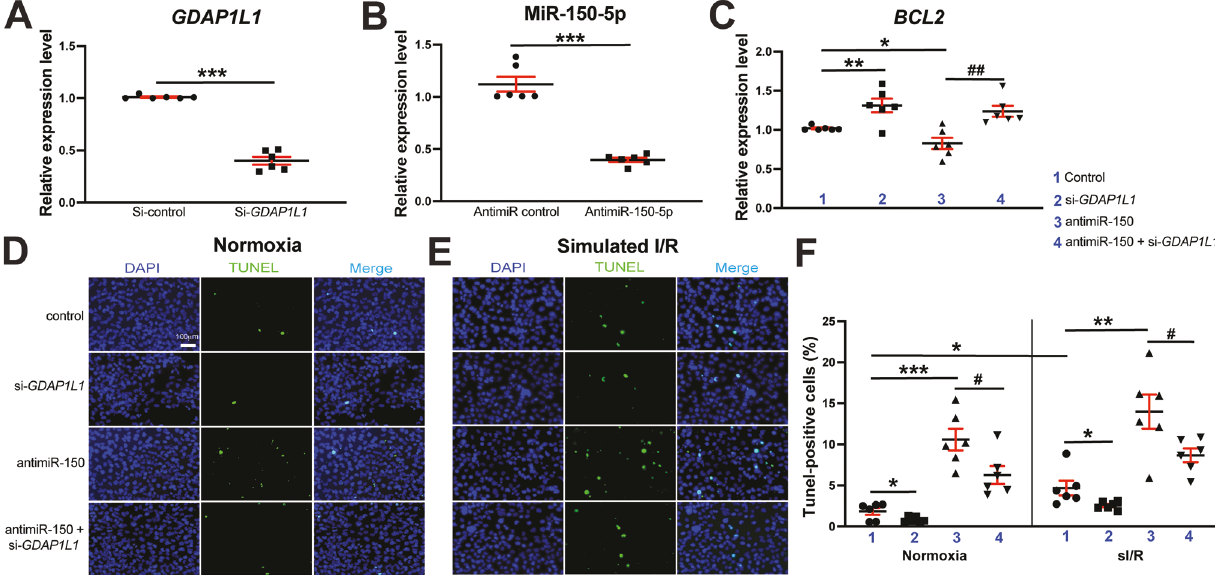
Fig. 8 GDAP1L1 is required for miR-150-dependent inhibition of human cardiomyocyte apoptosis. A , B AC16 cells were transfected with control scramble siRNA (si-control) or GDAP1L1 siRNA (si- GDAP1L1 ) ( A ) and with anti-miR control scramble or anti-miR-150 ( B ). QRT-PCR for GDAP1L1 ( A ) or miR-150 ( B ) was conducted to check the knockdown ef fi ciency. Data were normalized to GAPDH ( A ) or U6 SNRNA ( B ) and expressed relative to controls. N = 6 per group. Unpaired two-tailed t -test. *** P < 0.001 vs. si-control or anti-miR control. C QRT-PCR expression analysis of anti-apoptotic BCL2 in human cardiomyocytes (HuCMs) transfected with 4 different groups as indicated. N = 6. BCL2 expression compared to GAPDH was calculated using 2 − ΔΔ Ct , and data are presented as fold induction of BCL2 expression levels normalized to control (si- control or anti-miR control). One-way ANOVA with Tukey multiple comparison test. * P < 0.05 or ** P < 0.01 vs. control. ## P < 0.01 vs. anti-miR- 150. D – F RNA interference with GDAP1L1 protects HuCMs from the pro-apoptotic effects mediated by anti-miR-150. HuCMs were transfected as indicated and subjected to in vitro simulation of I/R (hypoxia/reoxygenation) [sI/R (H/R)]. TUNEL assays were then conducted in both normoxic ( D , F ) and sI/R conditions ( E , F ). Scale bar = 100 μ m. The percentage of apoptotic nuclei (green) was calculated after the normalization of total nuclei (blue). N = 6. One-way ANOVA with Tukey multiple comparison test. * P < 0.05, ** P < 0.01, or *** P < 0.001 vs. control. # P < 0.05 vs. anti-miR-150. All data are shown as mean ±